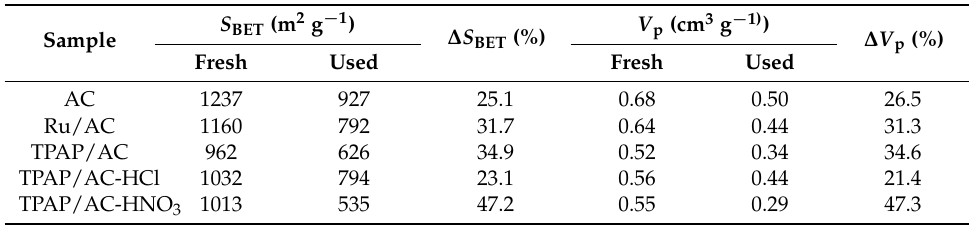
Table 1. The texture properties of the different samples a .